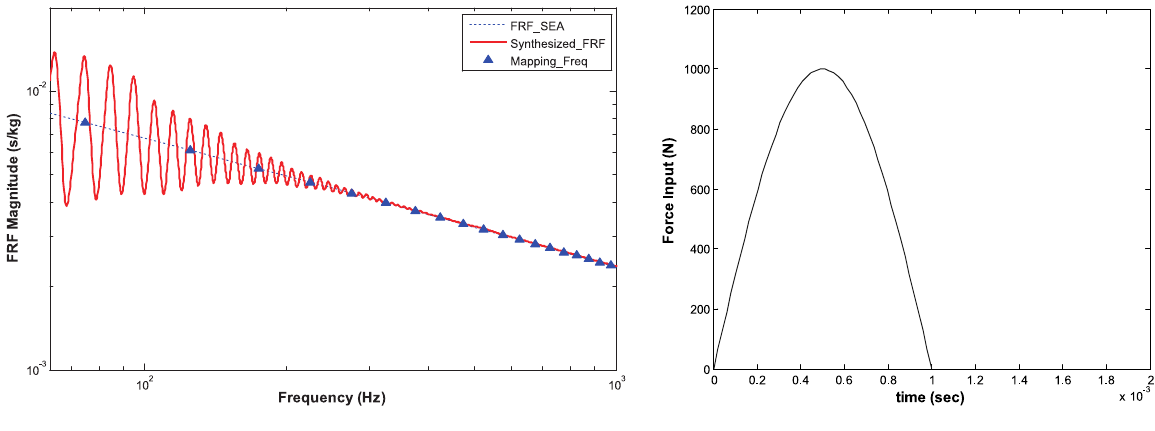
Fig. 13. FRF synthesizing by virtual modes (typical, panel #1). Fig. 14. Half sine input